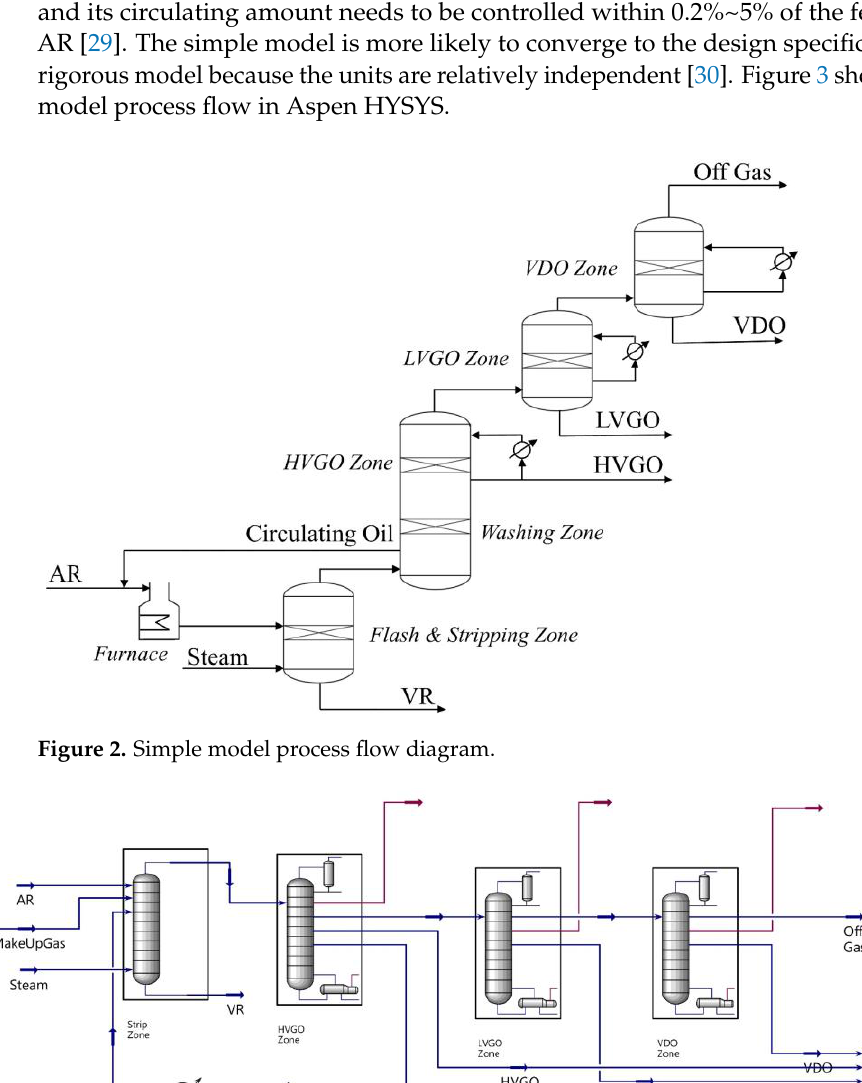
Figure 3. Process flow diagram for the simple model of VDU in Aspen HYSYS.